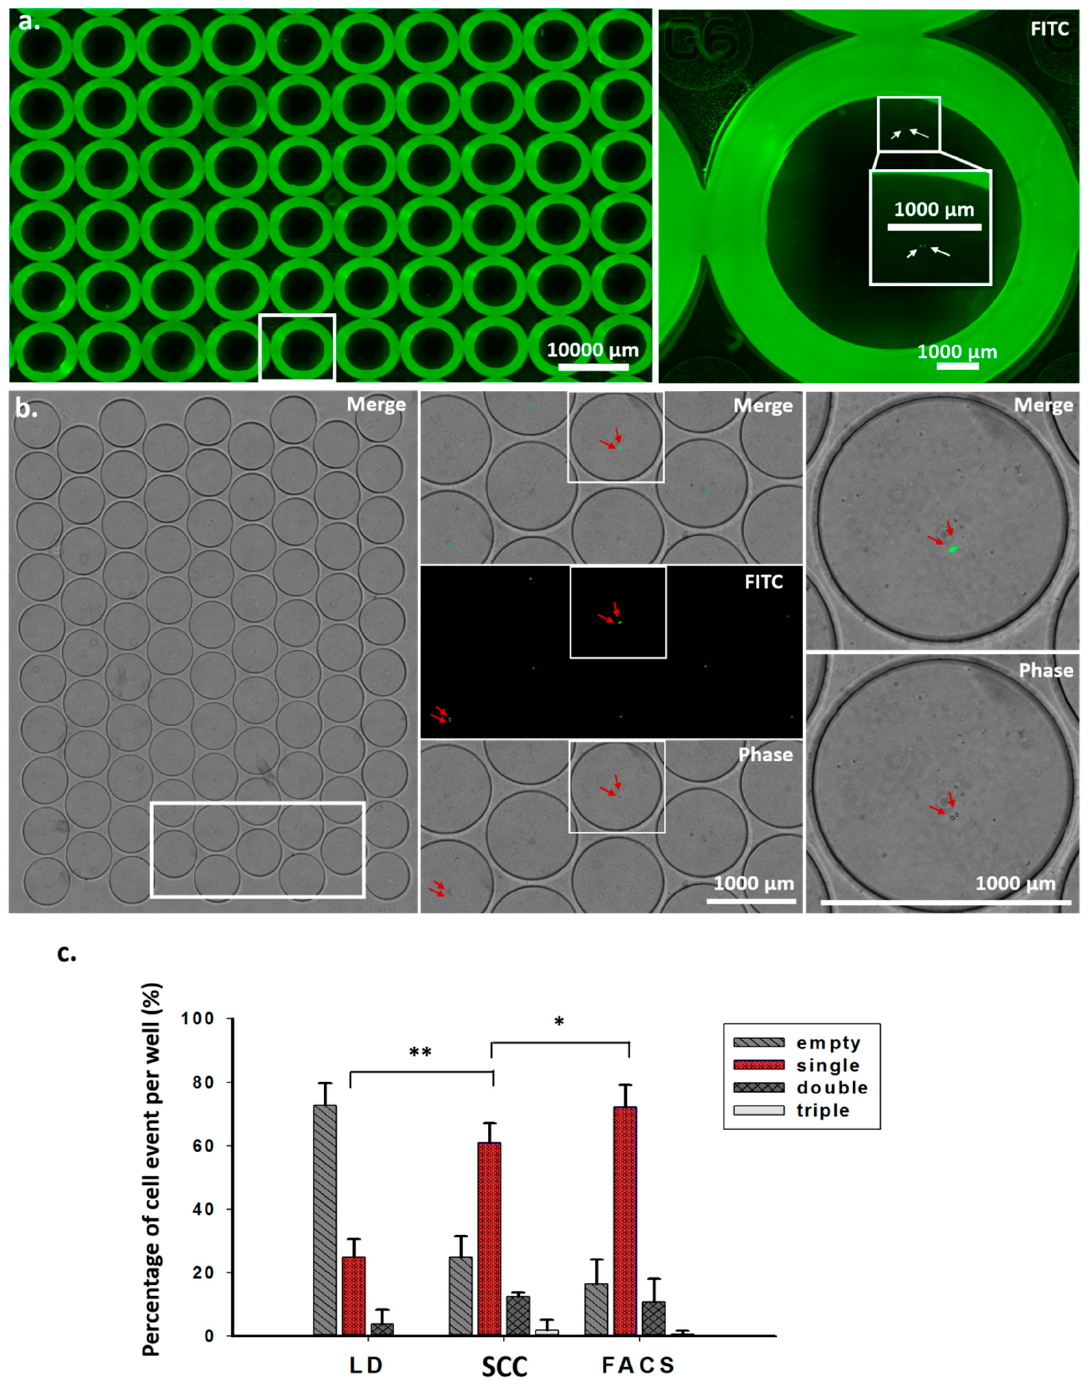
Figure 2. Validation and quantitative analysis of cell events in wells from scanned images. ( a ) Images were obtained by scanning 96-well plates after the individual cells were sorted through FACS for 30 min. Enlarged images show double cells in a well (right). ( b ) Images were obtained by scanning a microfluidic device within 10 min after the single cell was sorted (left). The white frame from the left image was enlarged (middle), showing merge, fluorescence, and phase images. Two arrows in each well indicate double cells. Enlarged images show merge and phase images of double cells (right). ( c ) Quantitative analysis of cell events per well after single-cell sorting using the limiting dilution method, the SCC device, and FACS. * p < 0.05., ** p < 0.005. Student’s t -test. n = 4, two independent